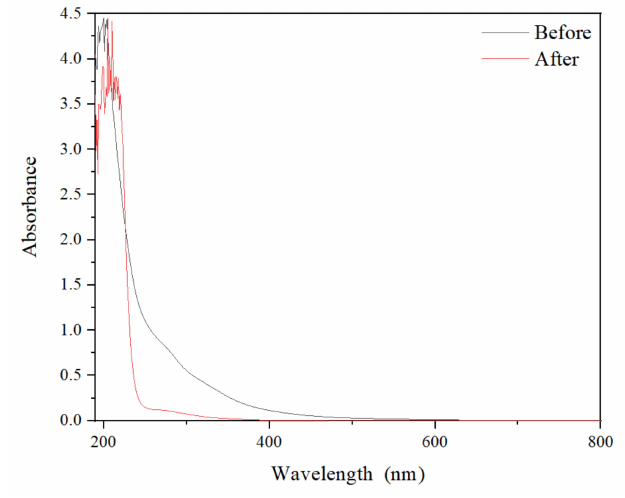
Figure 7. UV-Vis spectra of landfill leachate before and after treatment. (Initial pH: 3.0; PS/12COD ratio: 1; ZVI dosage: 1.5 g/L; current density: 62.5 mA/cm 2 ; reaction time: 6